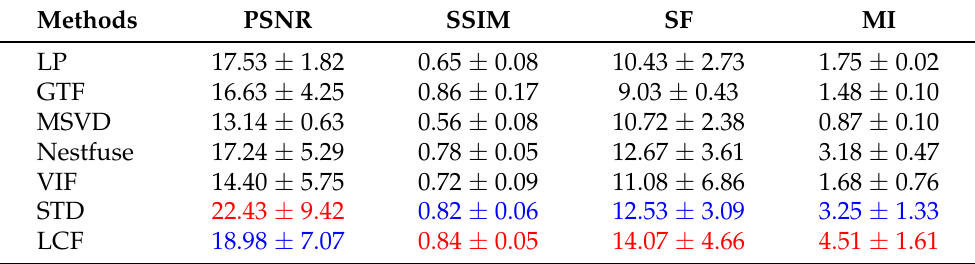
Table 1. Quantitative comparison of different methods for the fusion of TNO dataset. Red indicates the best result, and blue represents the second best